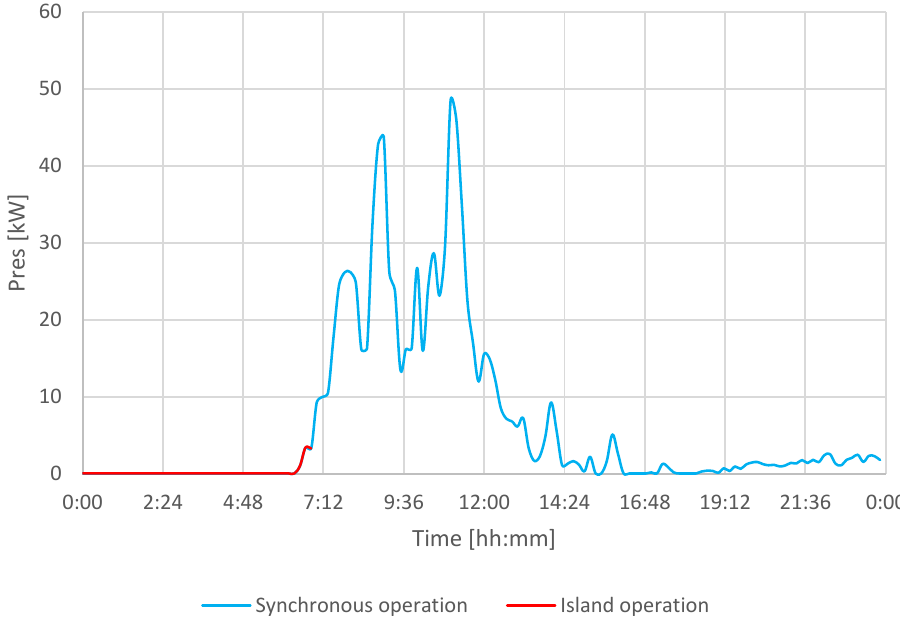
Figure 8. Daily changes of costs of operation of the hybrid test microgrid.